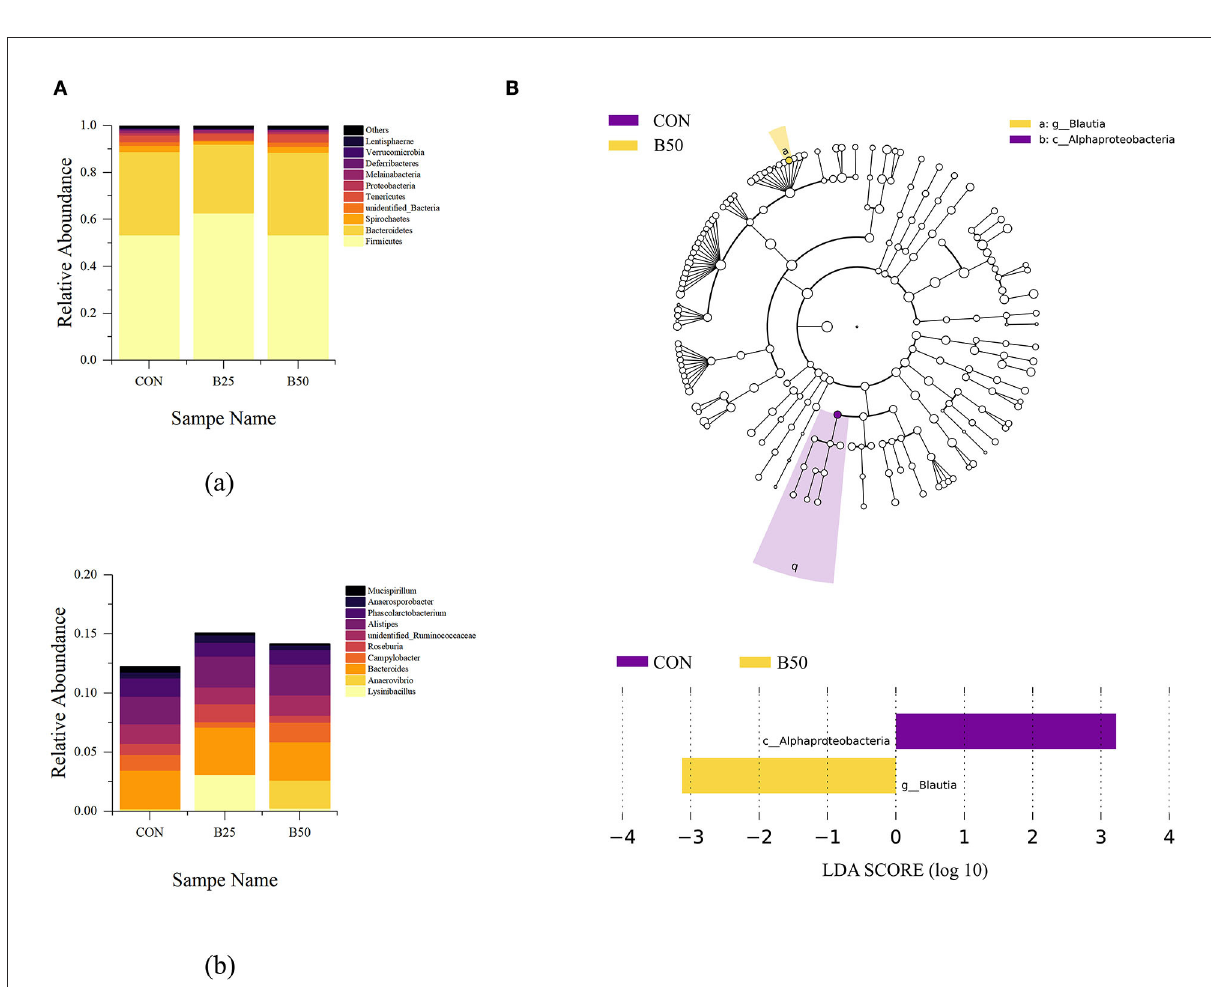
FIGURE5 Composition and linear discriminant analysis effect size (LEfSe) analyses of fecal microflora. (A) Component of fecal microbiota: (a) phylum level; (b) Genus level. (B) LEfSe analysis plot of fecal microflora.